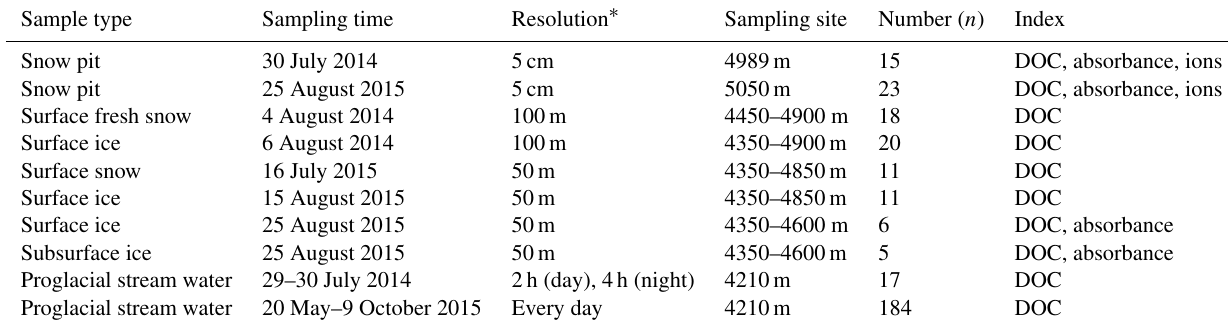
Table 1. Sampling information for snow, ice and proglacial stream water in this study. Sample